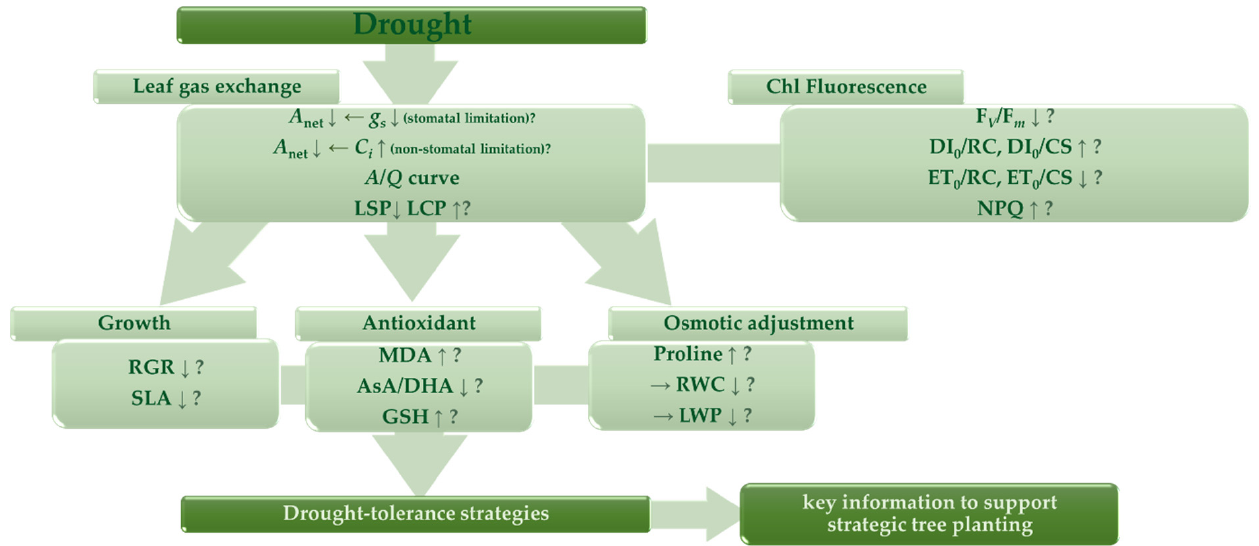
Figure 3. Key mechanisms and tolerance strategies to drought stresses in a tree. ↑ refers to the increase and ↓ refers to the decrease. ← means the deduction of a physiological or biochemical reaction in a tree response.